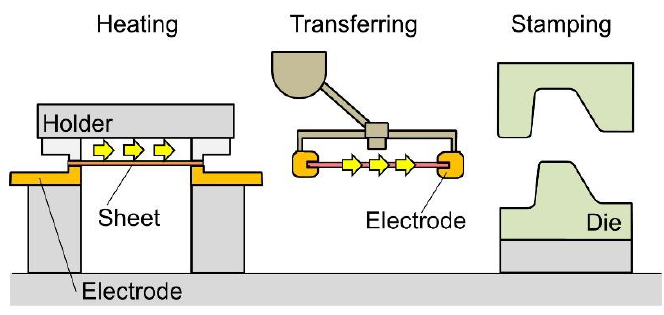
Figure 20. Maintaining temperature by installing electrodes on transfer manipulator.